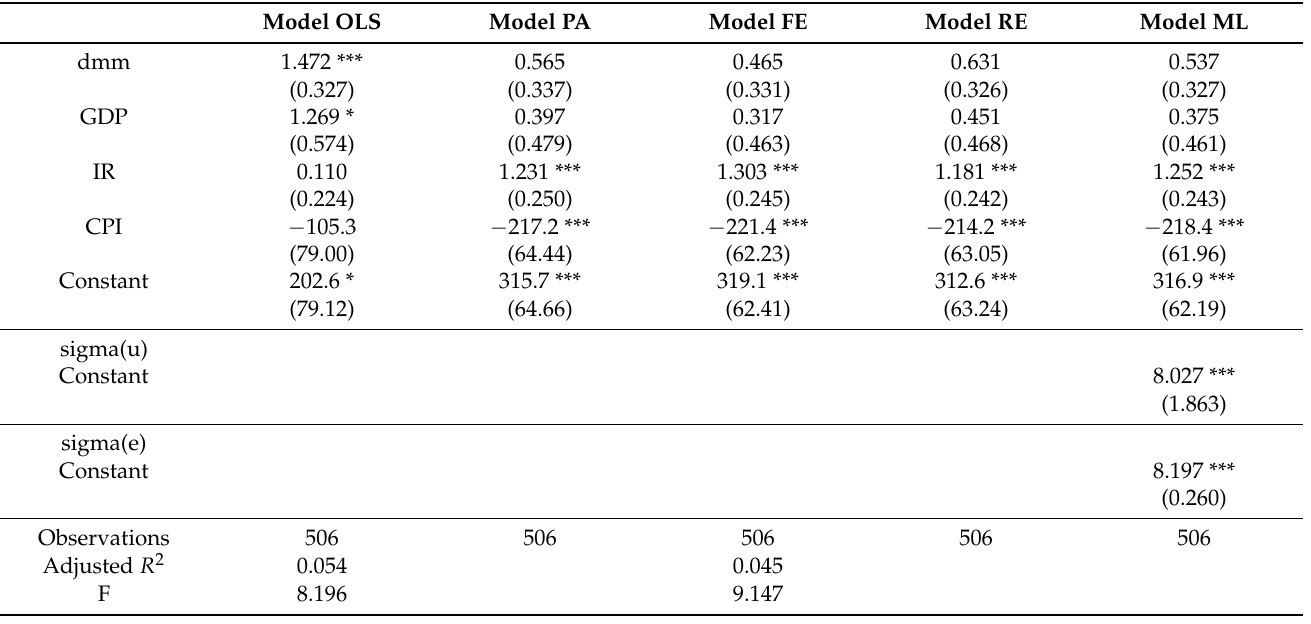
Table 5. Panel Regression Table OM